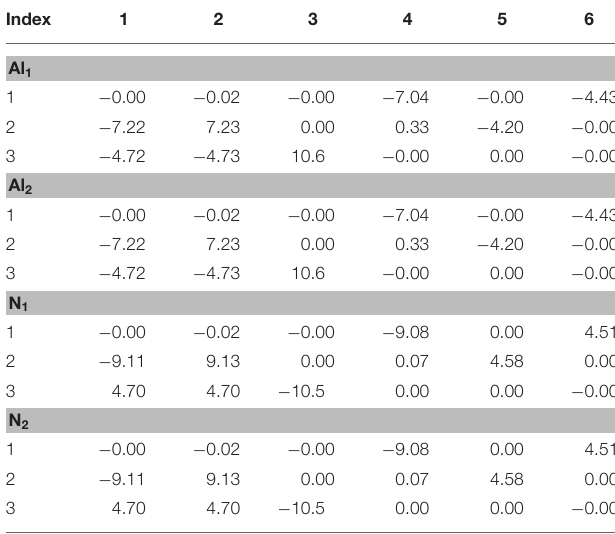
TABLE 5 | Internal strain tensor (Voigt notation) of Al 1 , Al 2 , N 1 , and N 2 for displacements in x, y, and z